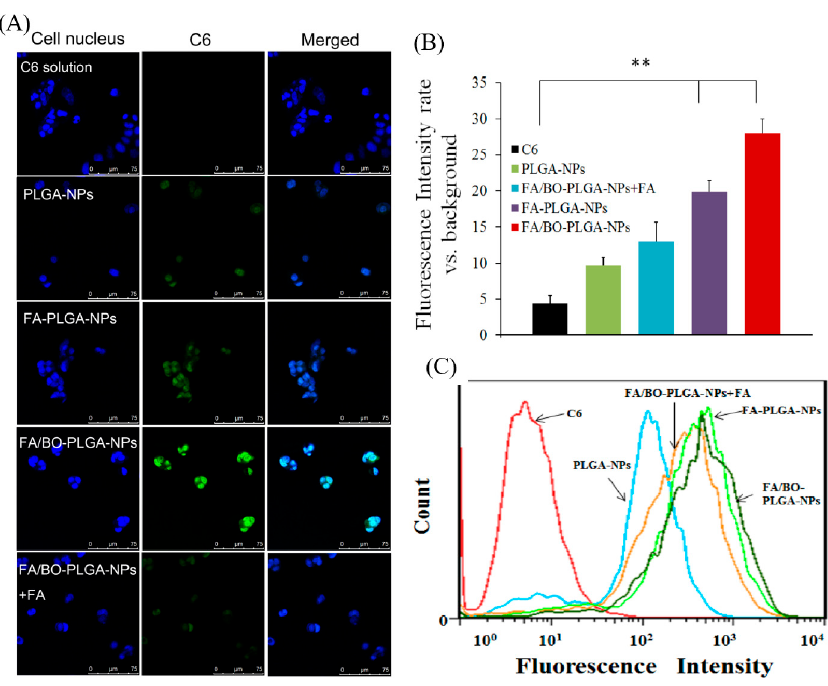
Figure 7. CLSM images ( A ) and fluorescence quantitative analysis ( B ) of Caco-2 cells after incubation with coumarin-6, PLGA-NPs, FA-PLGA-NPs, FA/BO-PLGA-NPs and FA/BO-PLGA-NPs with 2 mL FA (1 mM) for pre-incubated cells (coumarin-6 concentration of 300 ng/mL) for 4 h. Columns from left to right correspond to DAPI, coumarin-6 and an overlay of DAPI and coumarin-6, respectively. Flow cytometry results ( C ) of Caco-2 cells treated with coumarin-6, PLGA-NPs, FA-PLGA-NPs, FA/BO-PLGA-NPs and FA/BO-PLGA-NPs with 2 mL FA (1 mM) for pre-incubated cells (coumarin-6 concentration of 300 ng/mL) for 4 h. * p < 0.05, ** p < 0.01.